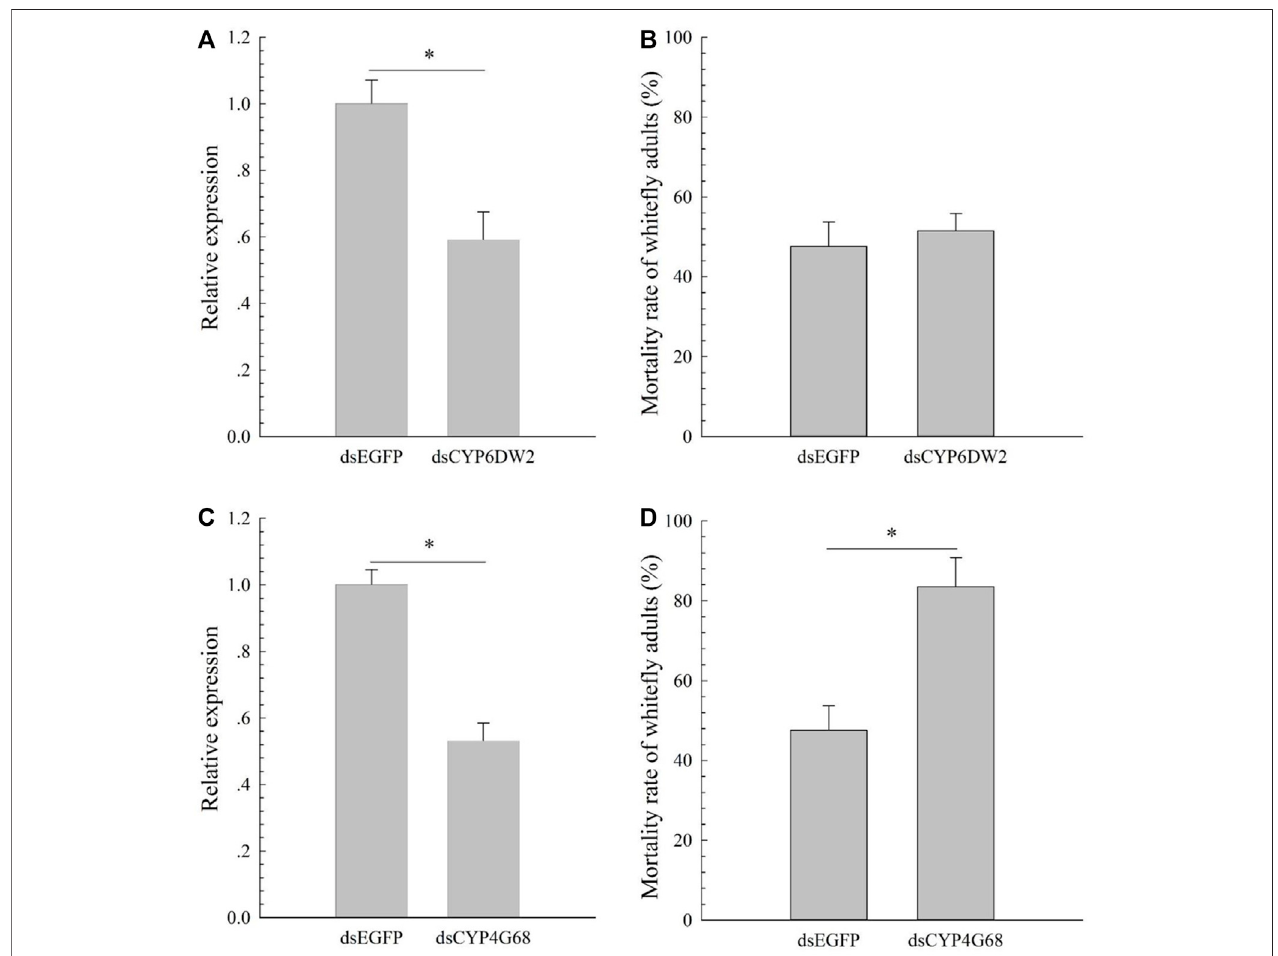
FIGURE 2 | Effects of dsCYP6DW2 on the expression of CYP6DW2 (A) and effects of silencing CYP6DW2 (B) on resistance to cyantraniliprole, and effects of dsCYP4G68 on the expression of CYP4G68 (C) and effects of silencing CYP4G68 (D) on resistance to cyantraniliprole.